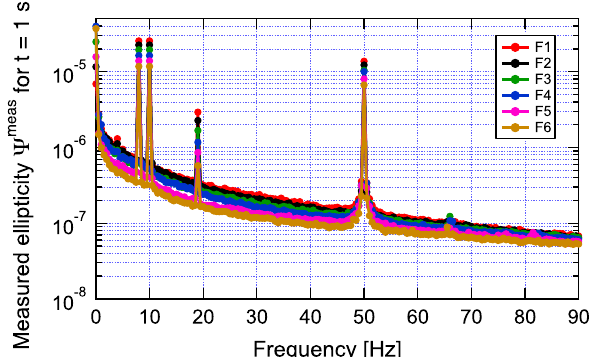
Fig. 10 Ellipticity spectra for the six finesse values rescaled to a 1 s integration time. The raw spectra have been rebinned by taking rms averages of the raw spectra in 0.5 Hz frequency intervals. The peak at 50 Hz is due to the